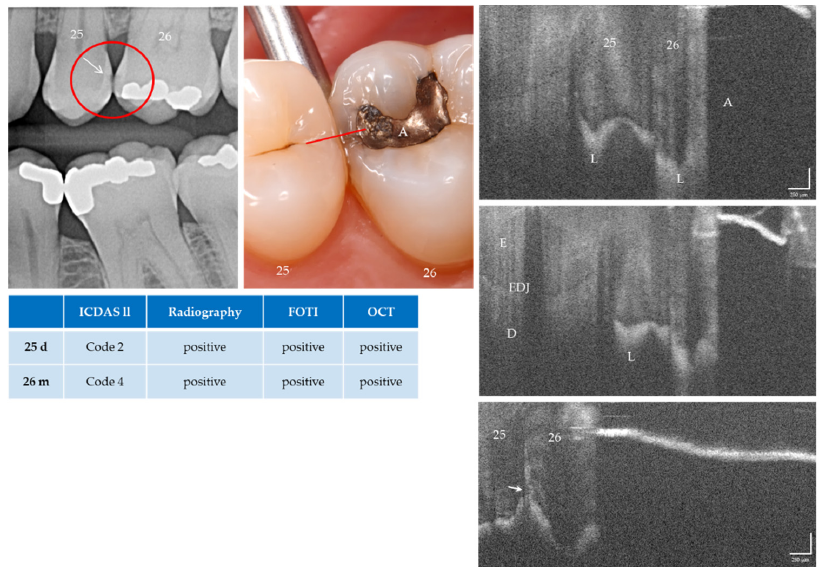
Figure 12. Teeth 25 (d) and 26 (m). All methods diagnosed enamel caries lesions (L, arrow). On tooth 26 mesial the lesion was located next to an amalgam filling (A). The lower OCT image shows an irregularity in the enamel surface (arrow). An extensive lesion became visible by varying the angle of light incidence. Above the lesion the structures in the enamel are clearly visible. Whether the inclined signal in the surface of tooth 25 is a cavitation cannot be determined with certainty. Further OCT images taken orally and vestibularly did not provide clear additional information. Dentin involvement of the lesion is suspected, but an exact assessment is not possible due to local shadowing. As a result of focusing on deeper structures, the tooth surface has flipped in the OCT images. Enamel (E), dentin (D), enamel-dentin junction (EDJ). The vertical scales are related to the refractive index n = 1.0 (see remark in Figure 4)